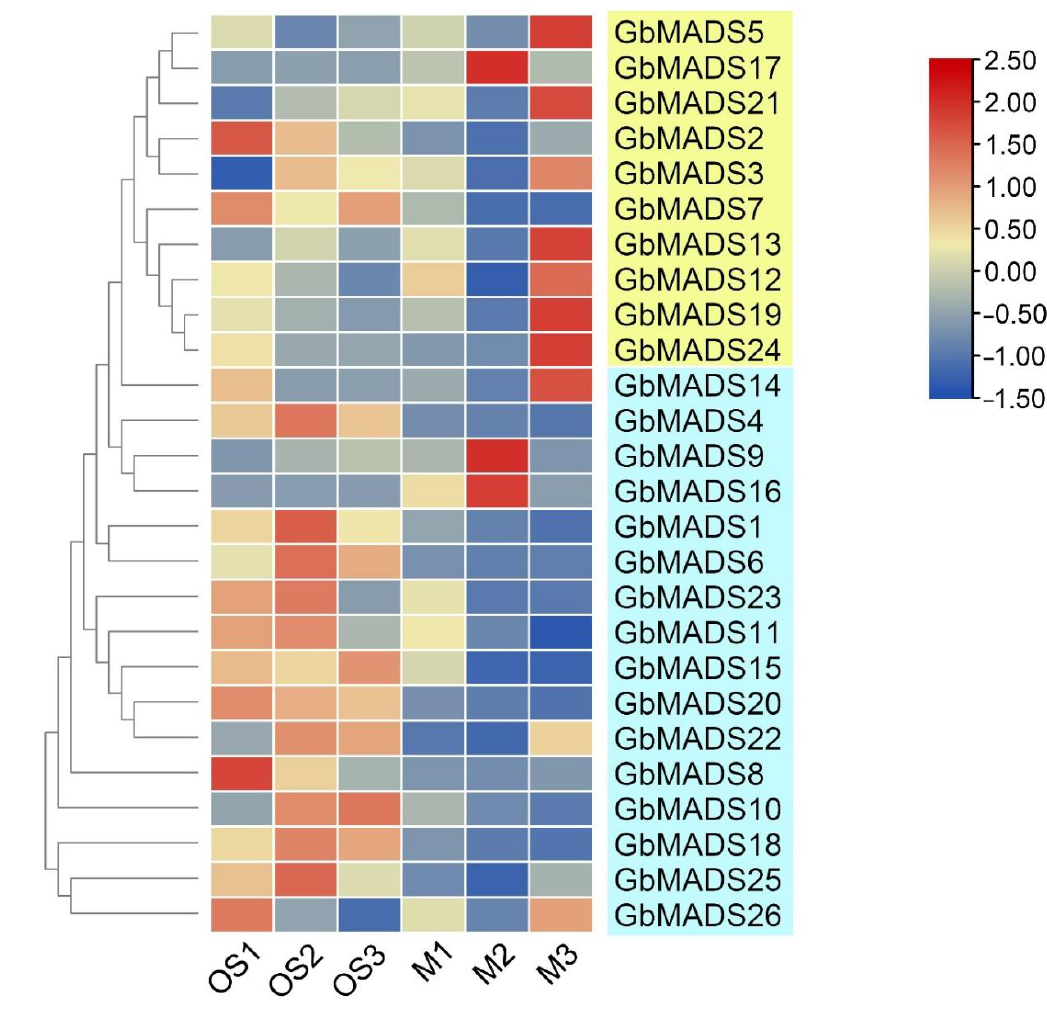
Figure 7. Heatmap representation of GbMADS genes in male and female flowers of G. biloba . The OS1, OS2, OS3, M1, M2, and M3 represent early development of ovulate strobilus, metaphase development of ovulate strobilus, later development of ovulate strobilus, early development of microstrobilus, metaphase development of microstrobilus, and later development of microstrobilus, respectively. The colored scale for the different expression levels was shown to the top right.